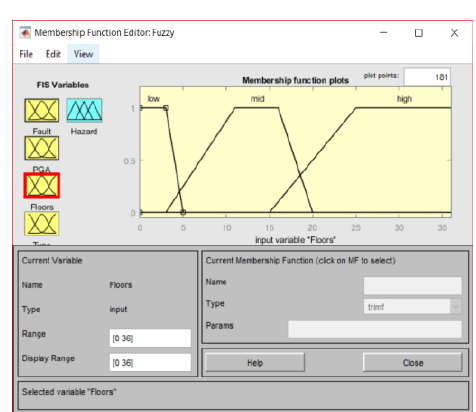
Figure 8. Number of floors' membership functions